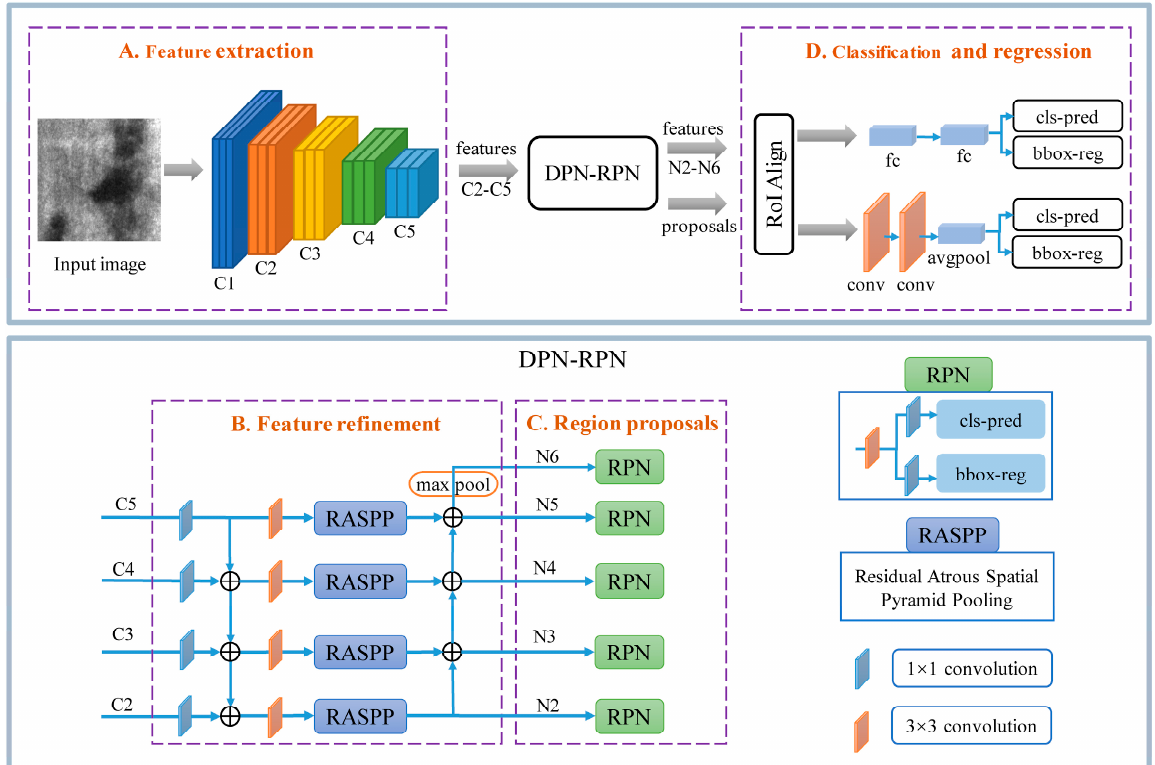
Figure 2. The overall framework of the proposed steel strip defect detection network (DPN-Detec- tor). cls-pred: class prediction, bbox-reg: bounding-box regression. fc: fully connected layer, conv: convolutional layer.